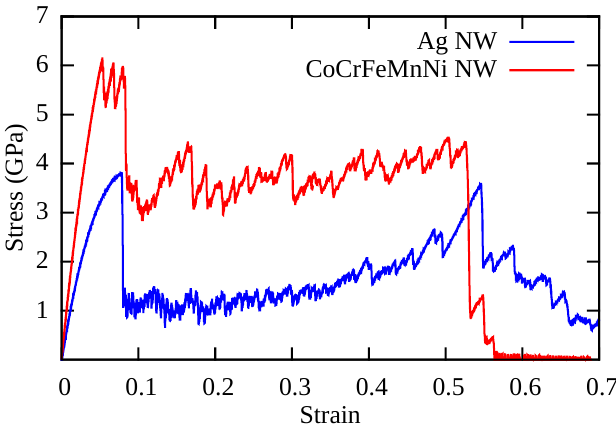
Figure 9. Stress–strain curves of Ag NW and CoNiCrFeMn HEA NW at 77 K. Both the nanowires show excellent superplasticity at cryogenic